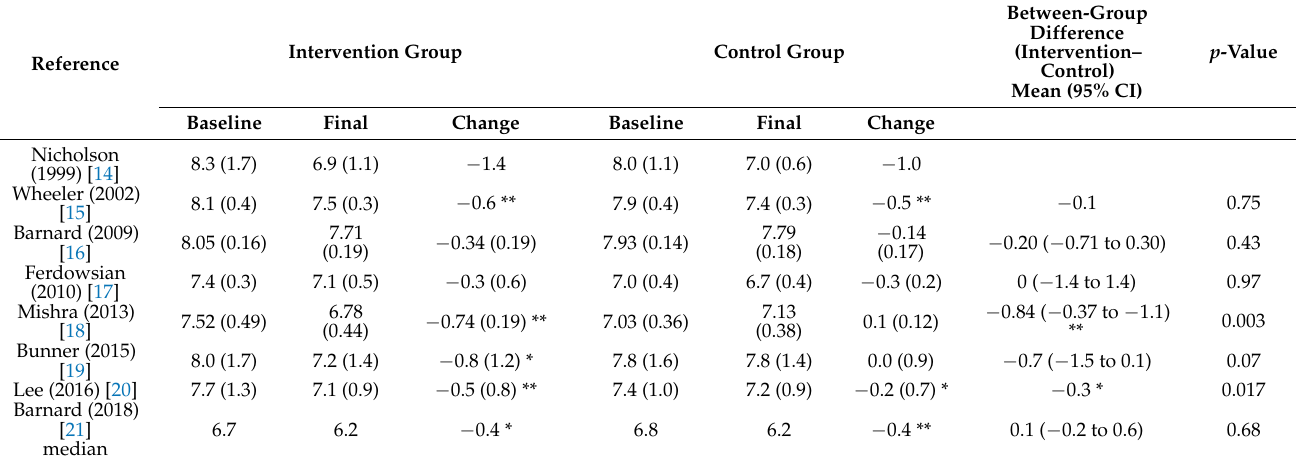
Table 3. Changes in HbA 1c levels (%) by group